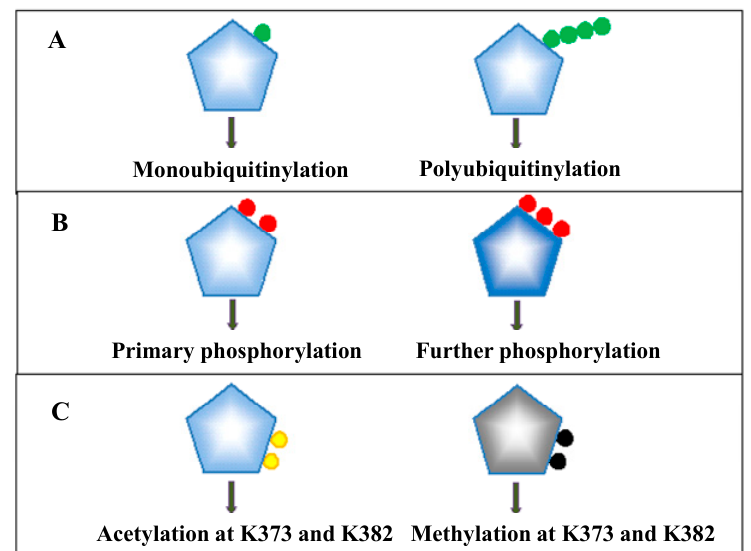
Figure 5. Posttranslational modifications of p53. ( A ) p53 can be ubiquitinylated by Mdm2 in mono- and poly-form at a single site and multiple sites. Polyubiquitinylated p53 can bear a polymeric ubiquitin chain with at least four subunits at a single lysine residue. Green dots indicate ubiquitin units; ( B ) p53 can be phosphorylated at Ser-12/20 facilitating cell cycle arrest. If DNA damage is not repaired, p53 is subsequently phosphorylated at Ser-46 leading to apoptosis. Red dots indicate phosphate groups; ( C ) p53 can be acetylated and methylated at K373 and K382. Yellow dots indicate acetyl groups, whereas black dots indicate methyl groups. The modifications regulate activation and inactivation of p53.